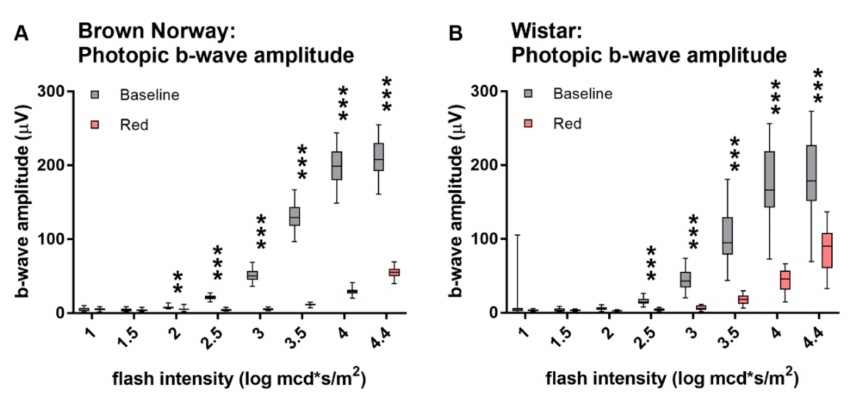
Figure 3. Photopic ERG responses to red and white light. Photopic b-wave responses to red and white light in Brown Norway ( A ) and Wistar ( B ) rats. Amplitudes of same intensity red light are considerably smaller than of white-light stimuli. Statistics: t-test corrected with Holm-Sidak method for multiple comparisons. ** p ≤ 0.01, *** p ≤